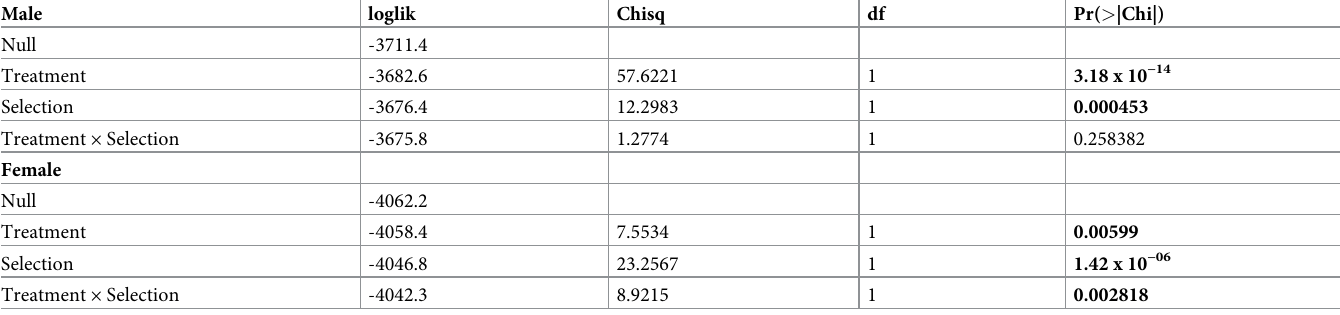
Table 1. Summary table of Cox proportional hazards analysis showing effect of selection, density treatment, and their interaction against Pseudomonas entomophila .